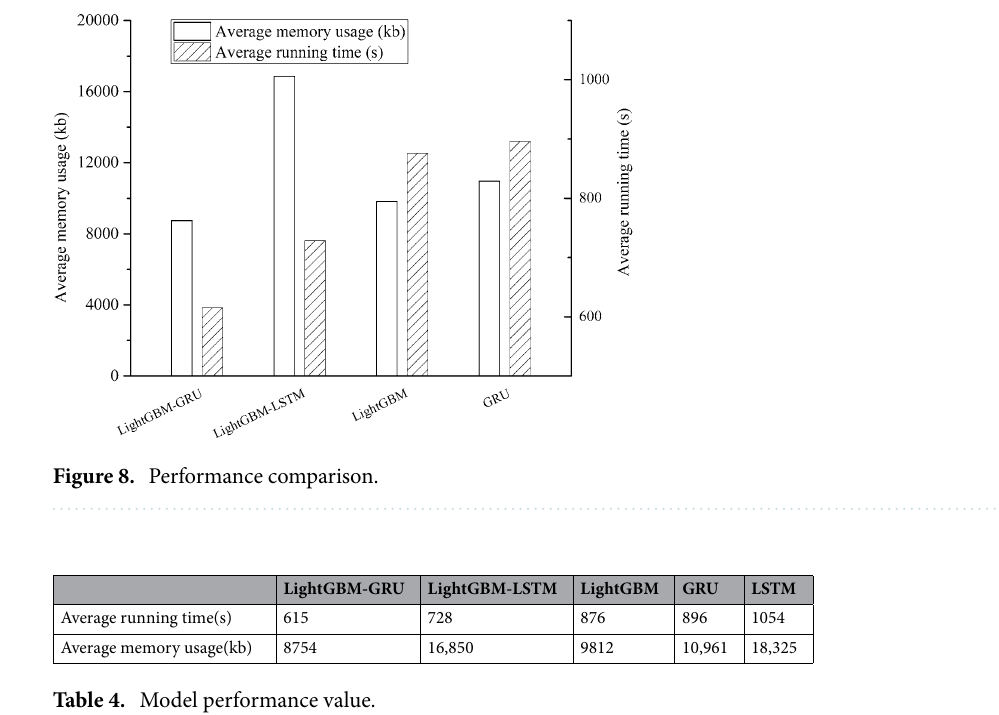
Table 4. Model performance